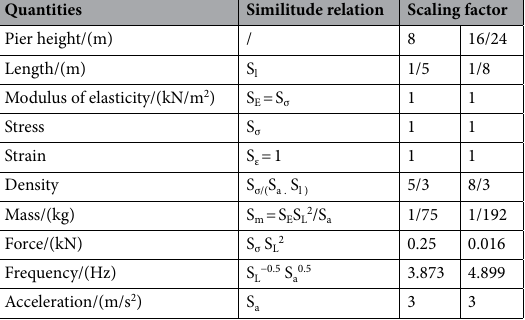
Table 2. Similitude parameters of high RERSCSS concrete piers used in the HSRB model.